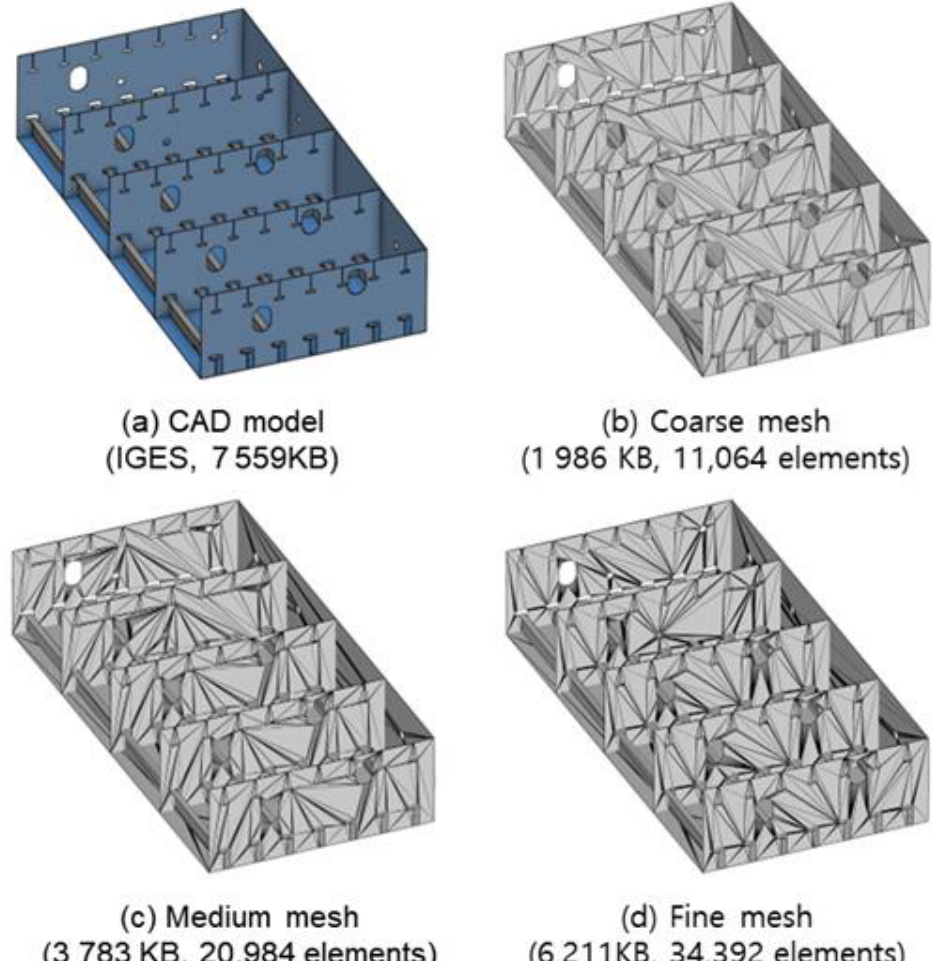
Figure 1. Comparison of data sizes of CAD and mesh models.